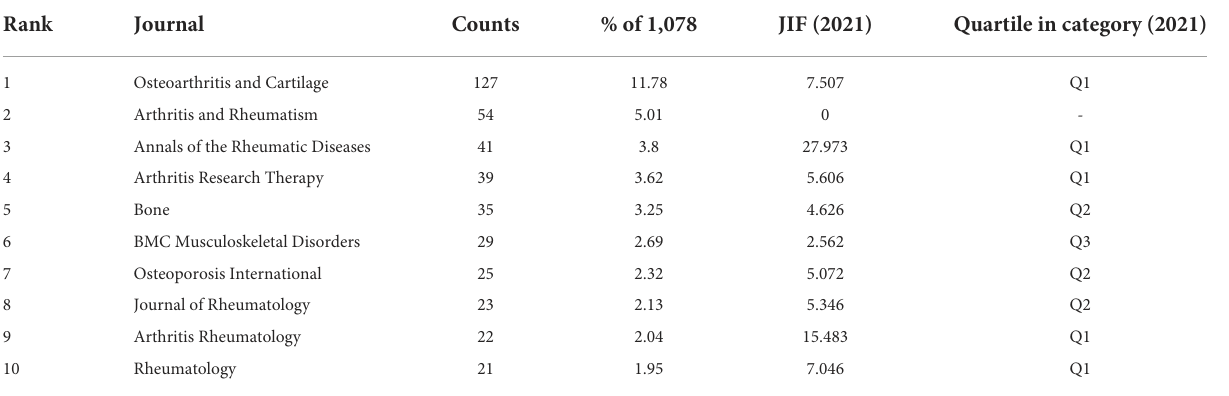
TABLE 4 Top 10 journals with the most